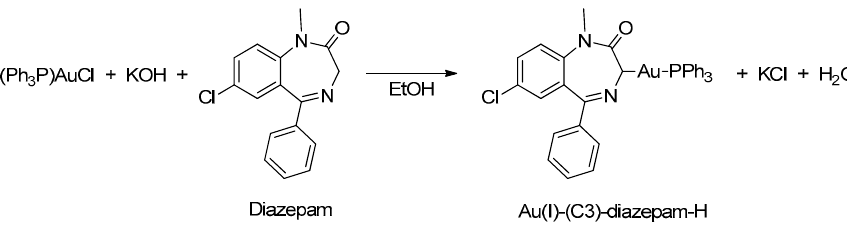
Figure 7. First example of organogold(I) derived from BZDs.